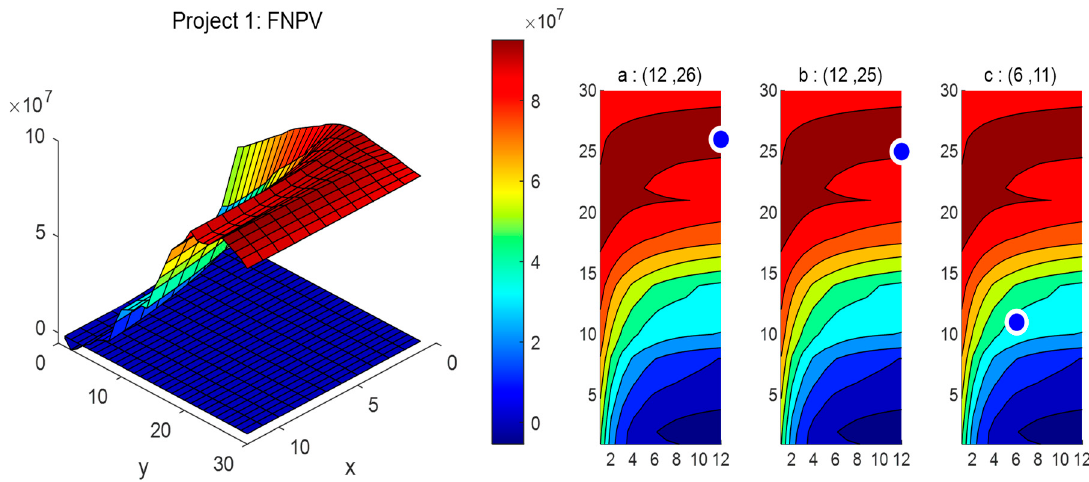
Figure 20. Decision-making for project 1. Figure 20. Decision − making for project 1.